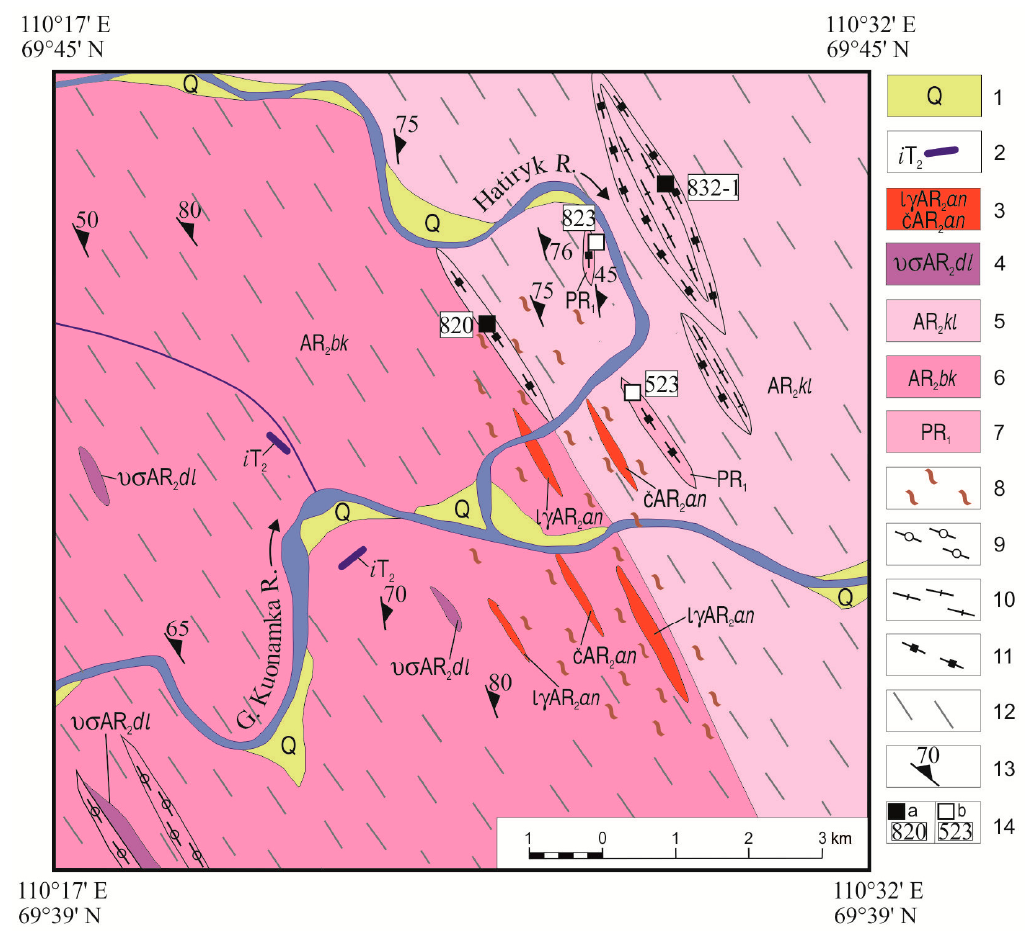
Figure 3. Geological map of the estuary part of the Khataryk River. (1) Quaternary rocks; (2) kimberlites; (3) charnockites, enderbites, and alaskan granites; (4) metamorphosed peridotites and pyroxenites. (5,6) Daldyn Group: (5) Kilegir sequence, including two-pyroxene schists, plagiogneisses, and quartzites; (6) Bekelekh sequence, including hypersthene, two-pyroxene plagiogneisses, and schists. (7) Paleoproterozoic metasedimentary rocks; (8) migmatization; (9) clinopyroxene and scapolite-clinopyroxene plagiogneisses; (10) garnet and pyroxene plagiogneisses; (11) quartzites; (12) orthopyroxene, two-pyroxene, and hornblende-pyroxene plagiogneisses; (13) strike and dip of gneissosity and foliation. (14) Localities and numbers of samples: (a) quartzites previously studied [9]; (b) presented in this paper.